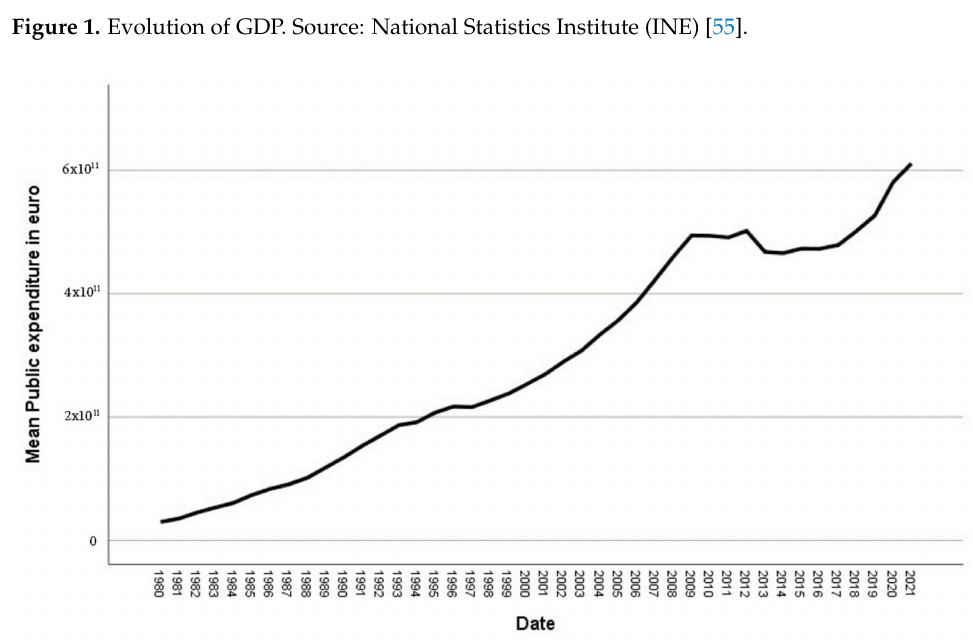
Figure 2. Evolution of public expenditure. Source: National Statistics Institute (INE)